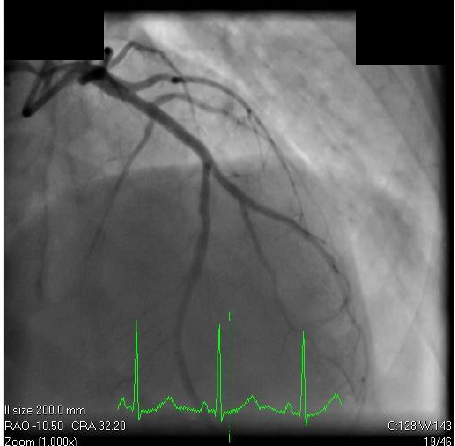
Figure 8. Coronary angiography postangioplasty. Cranial projection of the left coronary artery showed improved blood flow to the LAD and to the diagonal branch, without any intraprocedural complications.